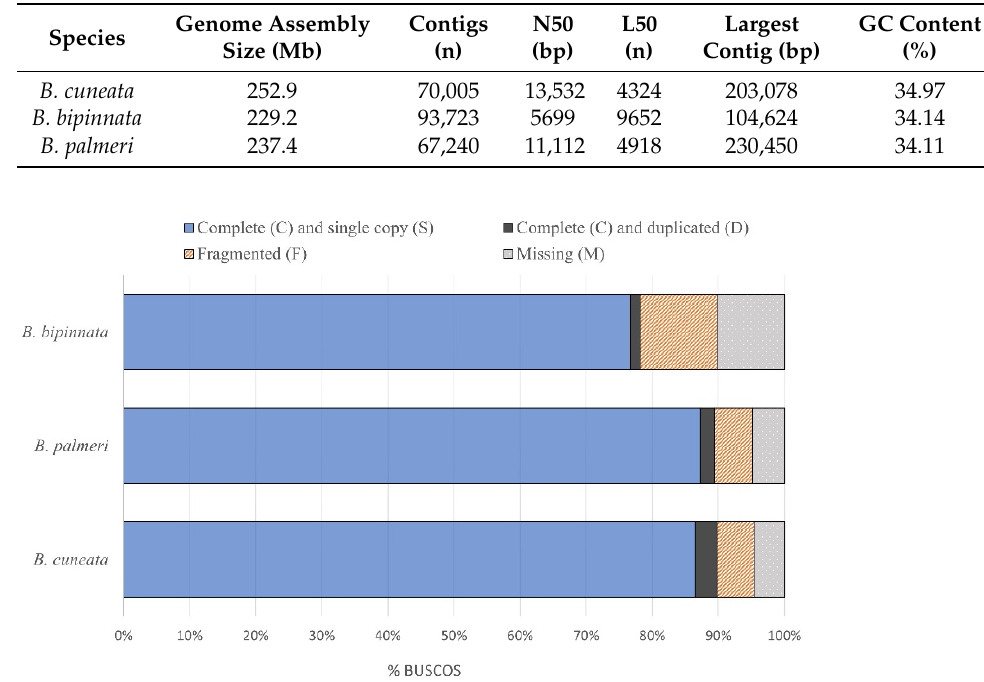
Table 1. Assembly metrics for three Bursera de novo nuclear genomes.